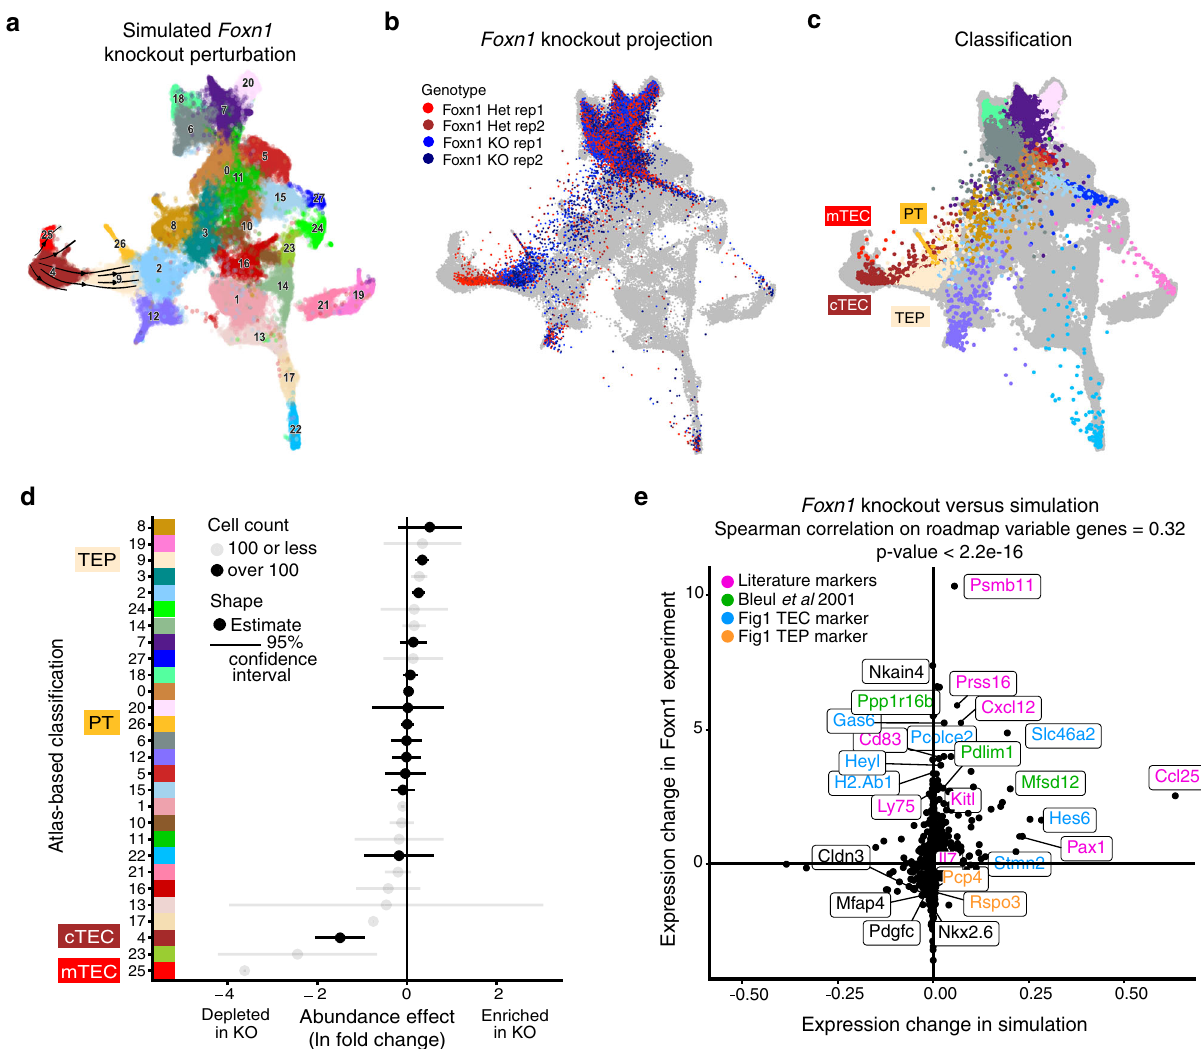
Fig. 5 Foxn1 knockout validates GRN models of thymus development and shows transcriptomic effects highly similar to a developmental block. a Visualization of an inducible Foxn1 knockout as simulated by CellOracle. Changes in gene expression between the simulated knockout and atlas cells are displayed as velocity streams on the UMAP embedding using scVelo. b , c UMAP visualizations of Foxn1 KO ( n = 2) and heterozygous control ( n = 2) data overlaid on the scRNA pharynx atlas. Each dot is one cell. Gray cells correspond to scRNA pharynx atlas. Colored cells are from the Foxn1 experiment, with color representing sequencing library (red, Foxn1 Het; blue, Foxn1 KO) ( b ) or classi fi cation (see Supplementary Fig. 3 for cluster color labels) ( c ). Classi fi cation and UMAP embedding of Foxn1 KO cells was done via nearest neighbors. d Cell-type-speci fi c abundance effects due to Foxn1 KO. Clusters and colors are taken from the classi fi er results in ( c ). Dots show the log fold change in abundance, and lines show a 95% asymptotic con fi dence interval based on quasi-Poisson regression. Clusters with fewer than 100 total cells are shown in gray. e Gene-by-gene comparison of the estimated log2-fold change from the Foxn1 KO experiment and the corresponding change predicted by the Foxn1 knockout simulation showing known and scRNA atlas identi fi ed thymus-speci fi c ( Psmb11, Prss16, Cxcl12, Ccl25 , etc., pink labels) 62 – 65 as well as thymus markers from the TEC progenitors and cTEC clusters (9 and 4, respectively) in our transcriptomic atlas ( Rspo3, Gas6 , blue and orange labels; Fig. 5e, Supplementary Datasets 1 and 6).